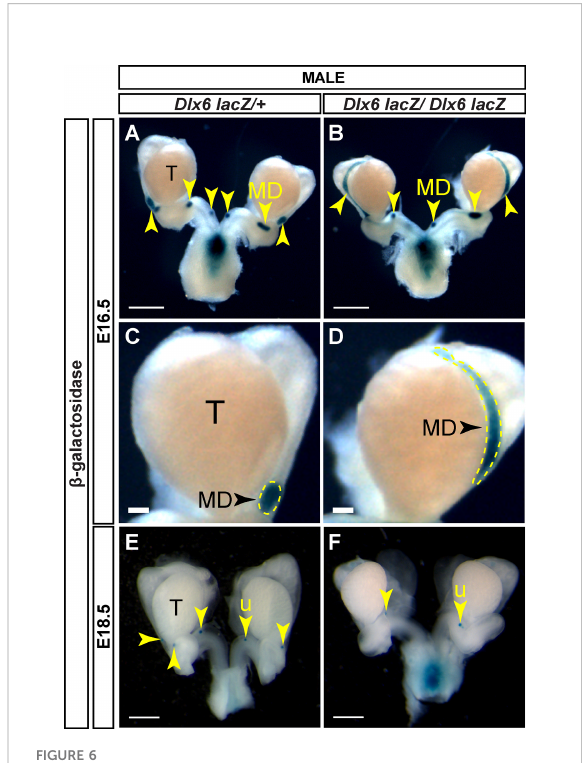
FIGURE 6 Loss of Dlx6 results in a delay in Müllerian duct regression. Wholemount b -gal-stained urogenital organs from E16.5 Dlx6- lacZ/+ (A) and Dlx6-lacZ/Dlx6-lacZ (B) male embryos. Higher magni fi cation of testis and adjacent Müllerian duct from E16.5 Dlx6-lacZ/+ (C) and Dlx6-lacZ/Dlx6-lacZ (D) male embryos. Wholemount b -gal-stained urogenital organs from E18.5 Dlx6- lacZ/+ (E) and Dlx6-lacZ/Dlx6-lacZ (F) male embryos. Arrowheads, residual Müllerian ducts (A-D) and uterus ( E, F ). Yellow dotted lines surround Müllerian ducts (C,D) . T, testis; MD, Müllerian duct; u, uterus. E16.5 Dlx6-lacZ/+ (n=5); E16.5 Dlx6- lacZ/lacZ (n=4); E18.5 Dlx6-lacZ/+ (n=5); E18.5 Dlx6-lacZ/lacZ (n=4). Scale bars = 500 µm (A, B, E, F) , 100 µm (C,D)